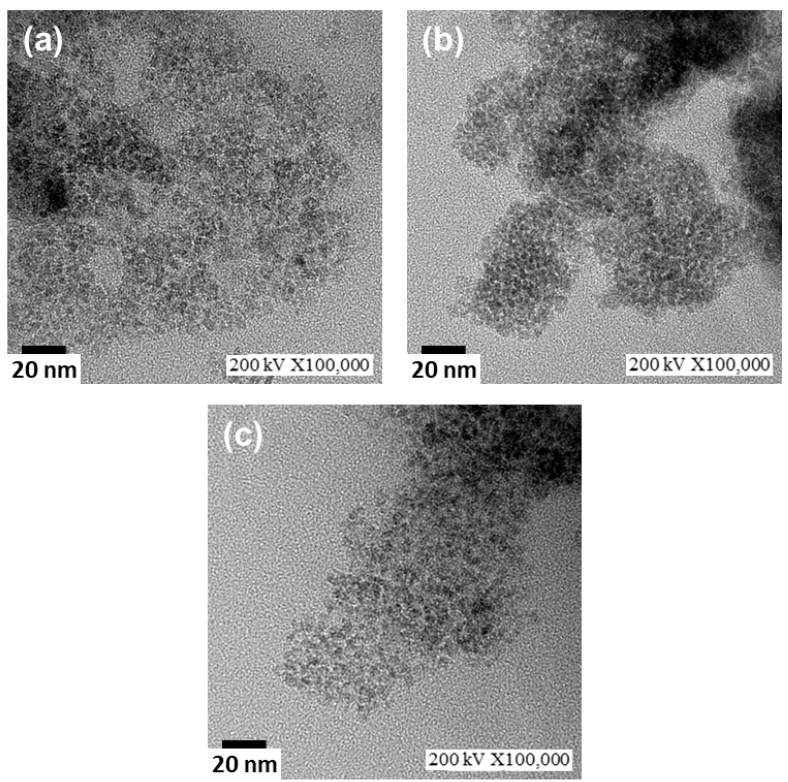
Figure 3. High-resolution transmission electron microscopy (HR-TEM) micrographs of Mg-based nanoferrites captured at a high magnification: ( a ) Mg, ( b ) Mg-Mn, and ( c ) Mg-Mn-In ferrite nanoparticles.